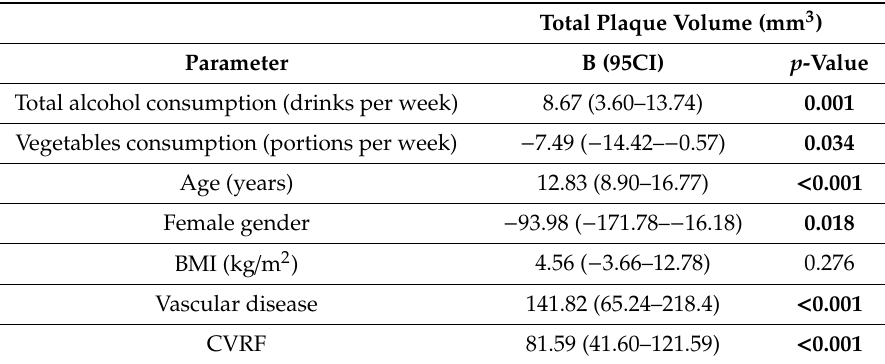
Table 4. Multivariate prediction model for total plaque